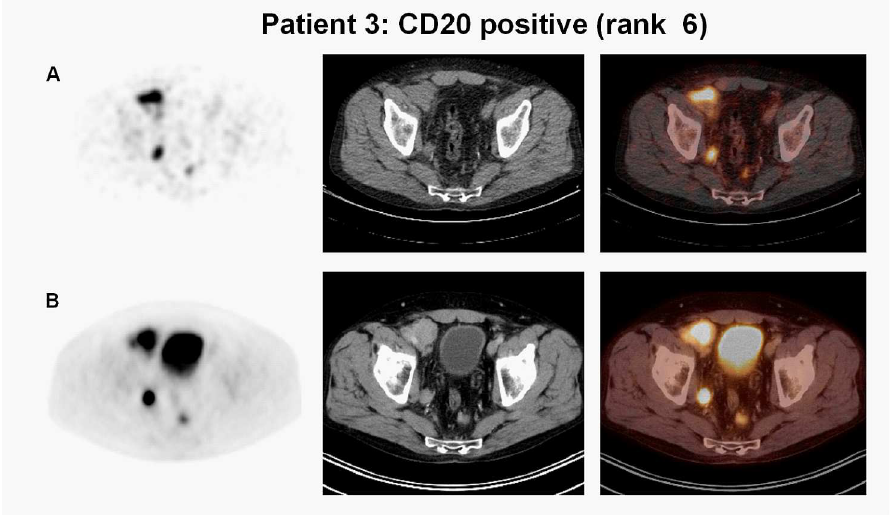
Fig 4. Example of tumor uptake on 89 Zr-rituximab-PET, concordant with CD20 expressionin biopsy. Axial images, from left to right attenuation corrected PET, low dose CT and fused PET/CT image of patient 3. a) 89 Zr-rituximab-PET shows intense tumor uptake concordant with a CD20-positive biopsy (inguinallymph node). b) Corresponding tumor locationon 18